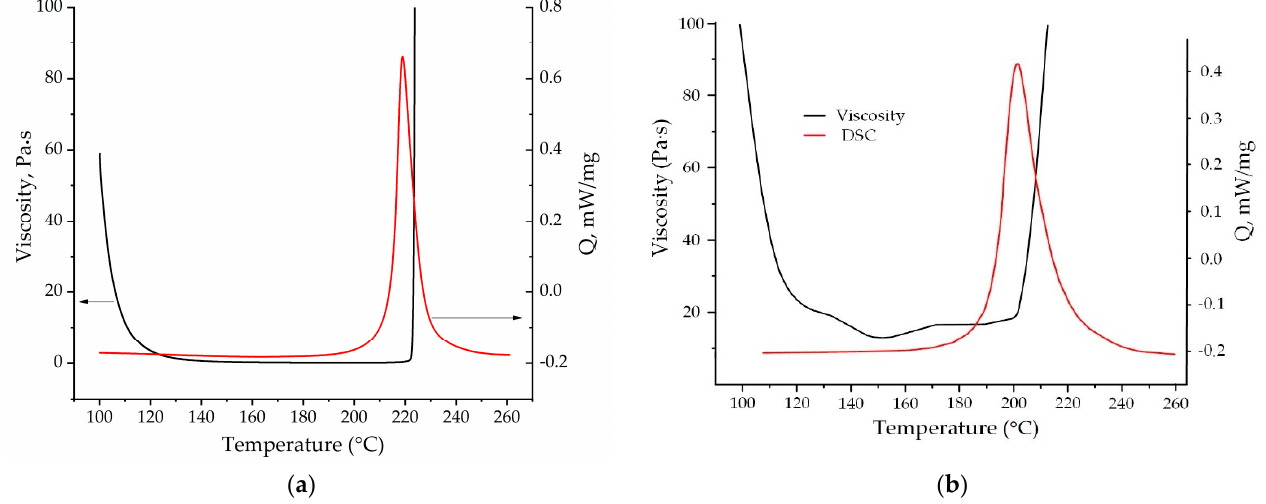
Figure 8. The comparison of viscosity (black) and DSC (red) curves of P-q ( a ) and P-d ( b ) at a heating rate 2 °C/min.